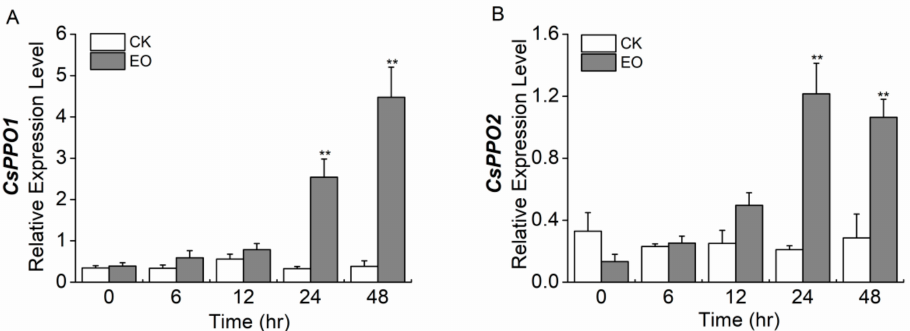
Figure 6. Mean levels of transcriptional expression ( ± SE) of ( A ) CsPPO1 and ( B ) CsPPO2 elicited in leaves of Camellia sinensis by the infestation of Ectropis obliqua . CsGAPDH was used as a reference gene. The asterisks indicate significant differences between treatments and controls (* p < 0.05, ** p < 0.01, Student’s t -test, n =